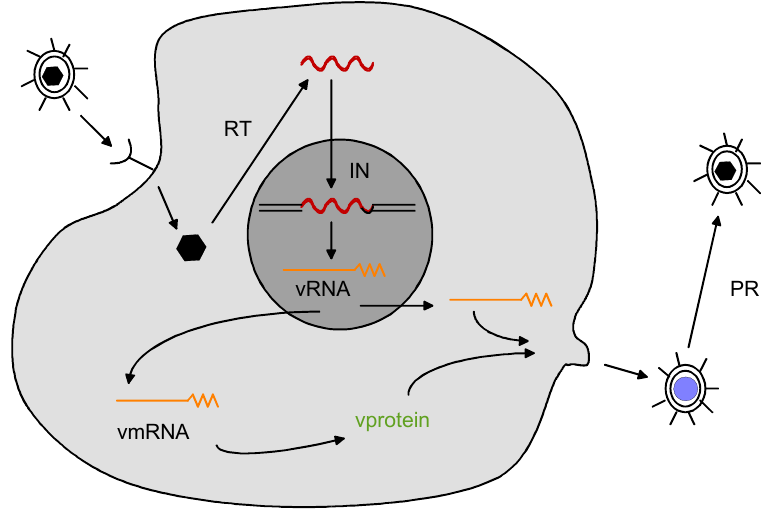
Figure 1. The retrovirus life cycle. See text for details.